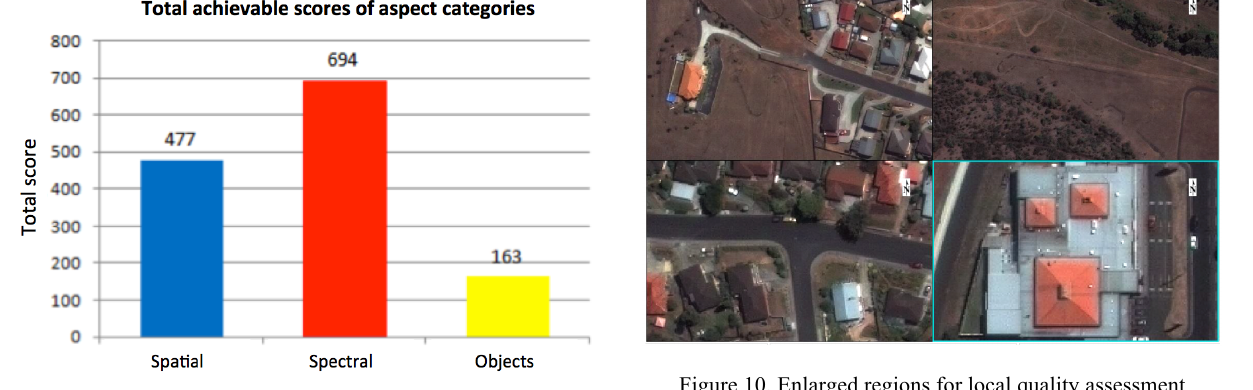
Figure 10. Enlarged regions for local quality